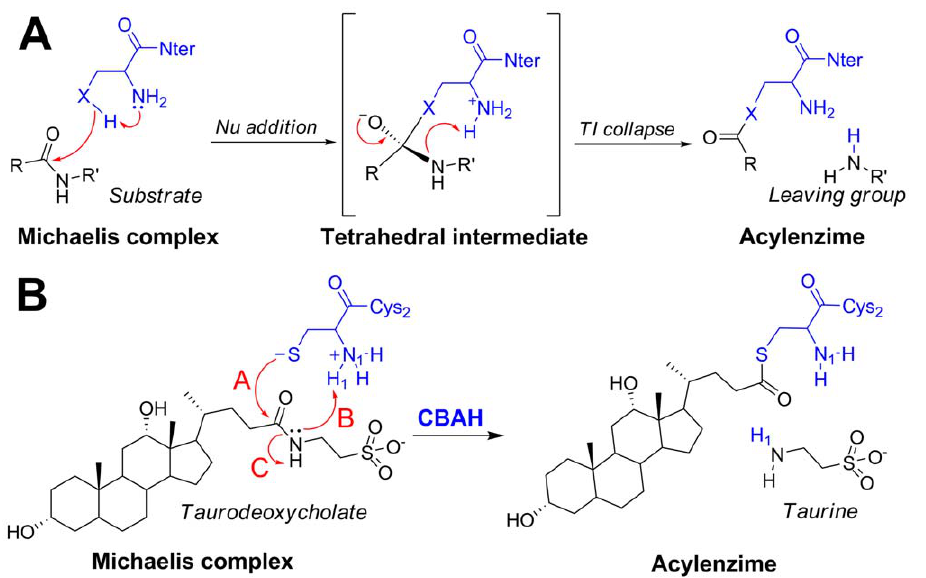
Figure 1. Catalytic mechanism of Ntn-hydrolases. Panel (A). The reaction begins when the nucleophilic oxygen/sulfur of Thr/Ser/Cys donates its proton to its own alpha-amino group and attacks the carbonyl carbon of the substrate [1], leading to a negatively charged tetrahedral intermediate (X represents oxygen or sulfur). The acylation step is completed when the alpha-amino group of the catalytic residue protonates the nitrogen of the scissile amide bond leading to the expulsion of the leaving group. Panel (B) First reaction of the catalytic mechanism of CBAH. A , B , and C are key steps for the cleavage of TAU amide bond.